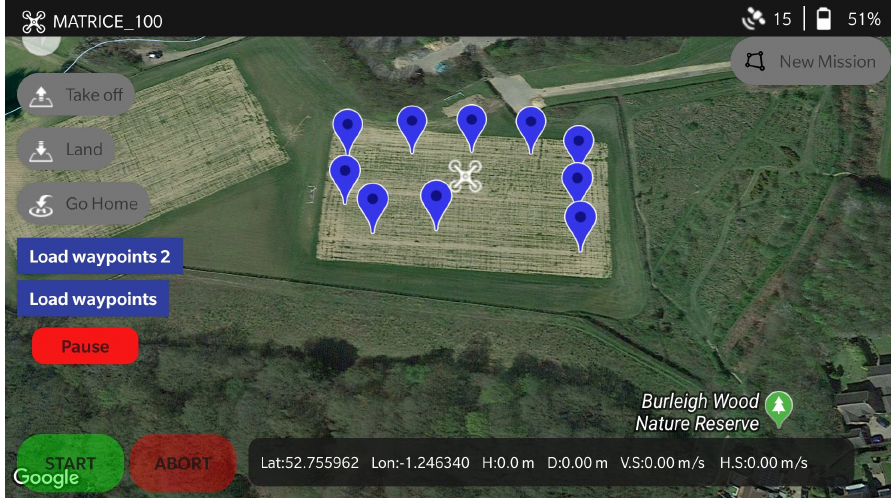
Figure 6. Interface for the high level mission planner.